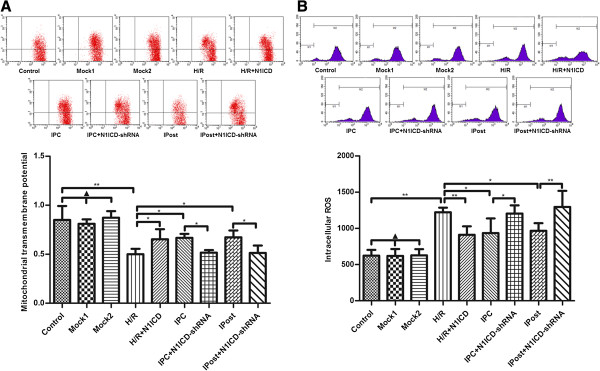
Notch1 signaling inhibits mitochondrial mPTP opening in H9c2 cells exposed to ischemia. A, Measurement of ΔΨm in different groups of H9c2 cells. B, Measurement of ROS accumulation in different groups of H9c2 cells. Data were presented as mean±SD, n=3. Mock1 indicated cells infected with empty vector, Mock2 indicated cells infected with vector containing nonspecfic sequences. ▲P>0.05, *P<0.05, **P<0.01.